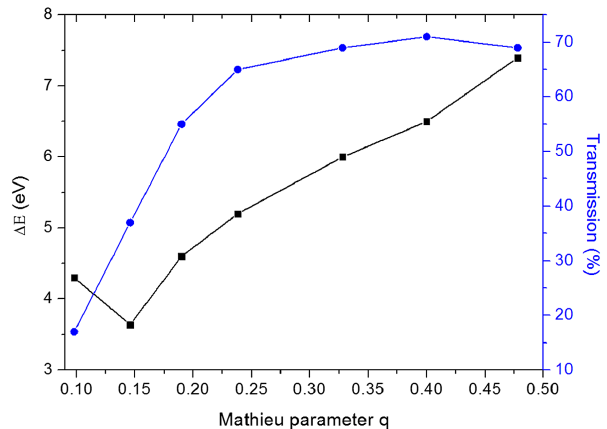
FIG. 3. Space charge effect on the longitudinal energy spread: experimental results of the beam current effect on the longitudinal energy spread at the RFQC exit [16].